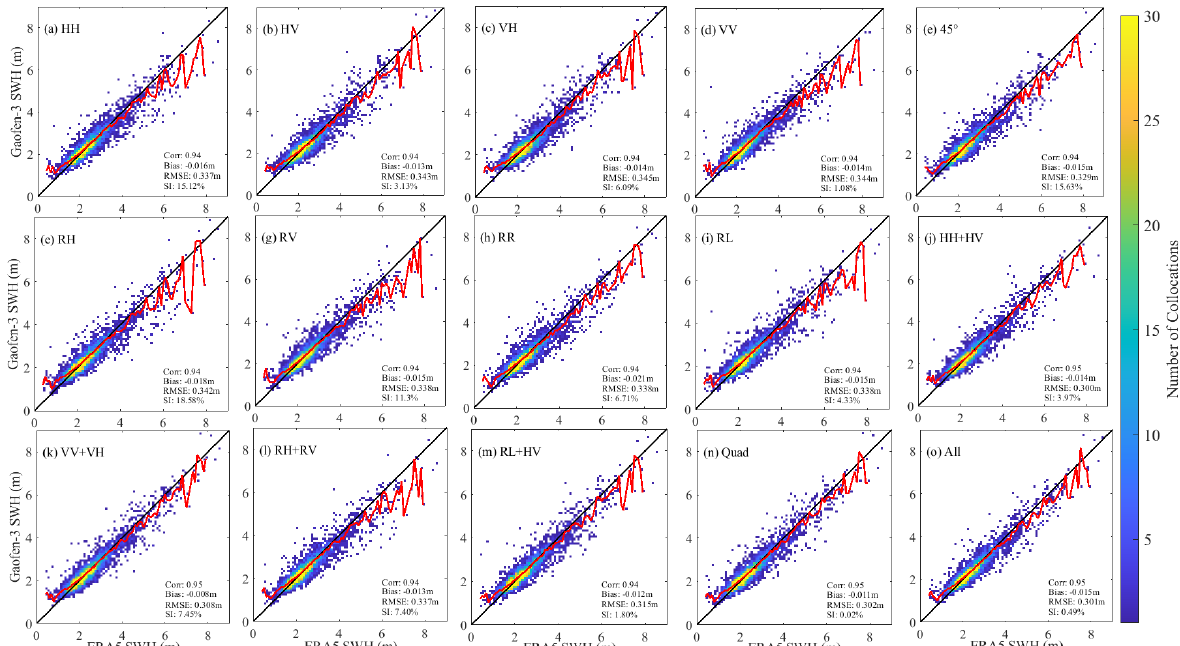
Figure 8. Plots of Gaofen-3 SWH retrievals from the XGBoost model using optimal feature sets versus ERA5 SWH for the 15 polarization modes of ( a ) HH, ( b ) HV, ( c ) VV, ( d ) VH, ( e ) 45° linearly, ( f ) RH, ( g ) RV, ( h ) RR, ( i ) RL, ( j ) HH + HV, ( k ) VV + VH, ( l ) RH + RV, ( m ) RL + HV, ( n ) Quad, ( o ) All. The solid red lines join the mean values from SAR estimates in each 0.1 m bin of ERA5 SWH. Colors denote the data numbers within 0.1 m × 0.1 m bins.